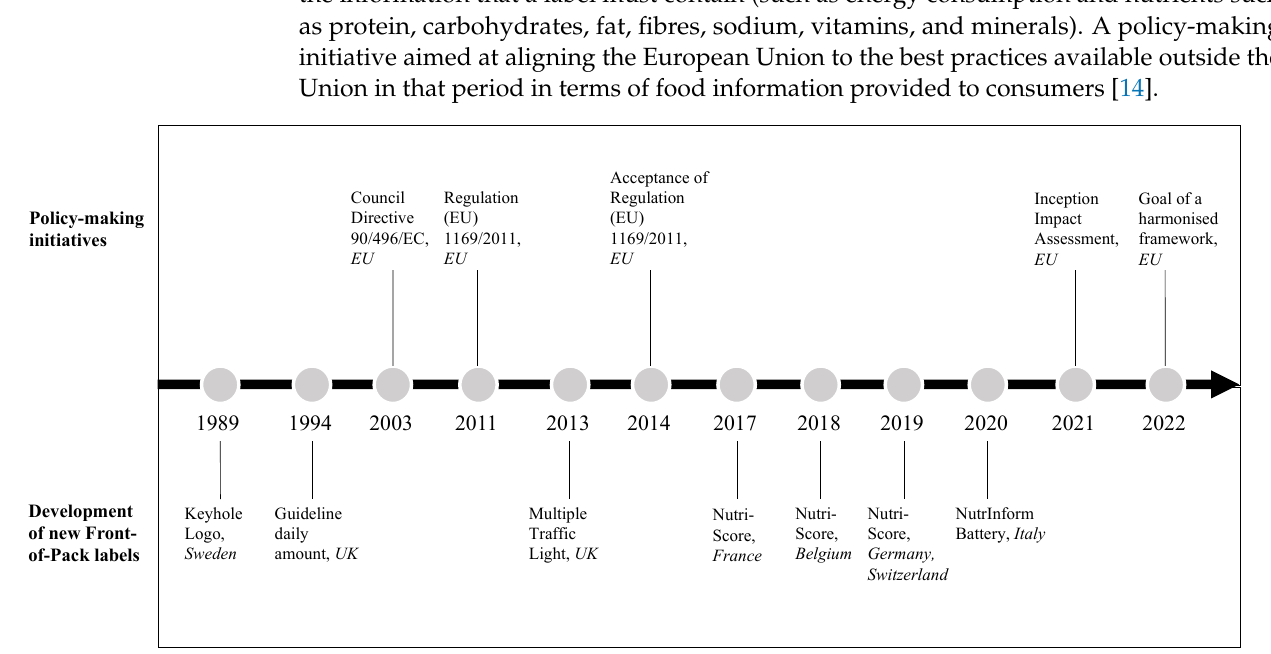
Figure 1. Evolution of policy-making initiatives and FoPL.